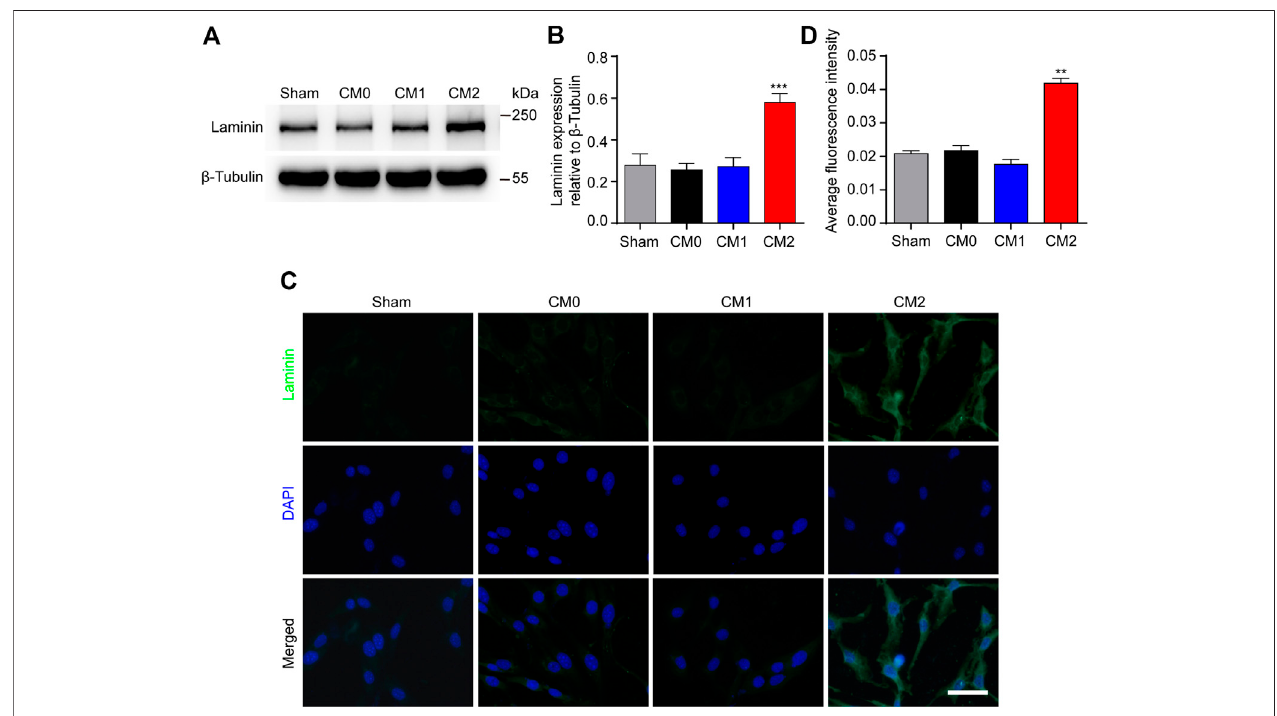
FIGURE5| M2macrophagespromotePDGFR β + pericytestosecreteextracellularmatrixLaminin invitro . (A) Westernblotwasusedtodetecttheexpressionlevels of Laminin in PDGFR β + pericytes after being treated in Sham, CM0, CM1 or CM2 groups for 24 h ( n (cid:2) 5 per group). (B) Quantitative analysis of Laminin expression. The blots were quanti fi ed as previously described. *** p < 0.001 (CM2 vs. other groups). (C) Immunocytochemistry stainingwasused to further con fi rm the expression levels ofLamininofPDGFR β + pericytesafterbeingtreatedinSham,CM0,CM1orCM2groupsfor24 h( n (cid:2) 3pergroup) (D) Quantitativeanalysisof fl uorescenceintensity in (C) . The results were expressed as mean ± SD. ** p < 0.01 (CM2 vs. other groups). Scale bar, 25 μ